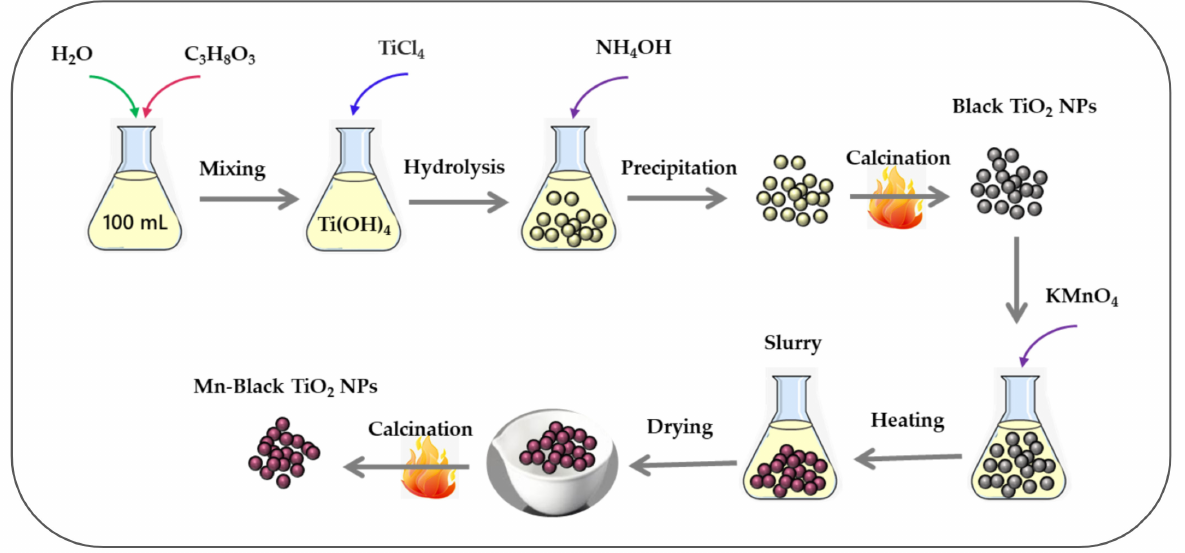
Figure 1. Scheme for the synthesis of black TiO 2 and Mn-modified black TiO 2